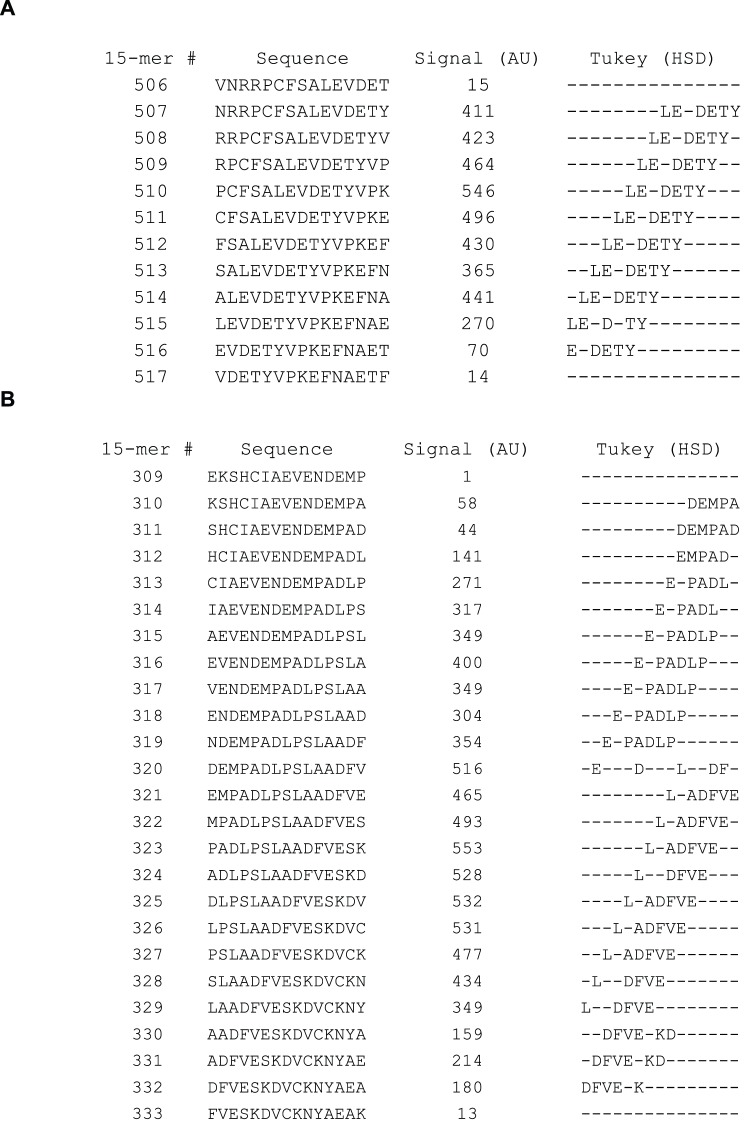
Example of Tukey’s HSD.The figure shows two examples example of epitope sequences identified using ANOVA followed by Tukey’s HSD post-hoc analysis. The leftmost column shows overlapping 15-mer peptides from HSA from position 510–527 in figure 3A and from position 309 to 333 in figure 3b. The rightmost column highlights the amino acids identified as being important for antibody binding (dashes indicate non-important positions). The important amino acids were determined on the p<0.01 level in the HSD post-hoc analysis.